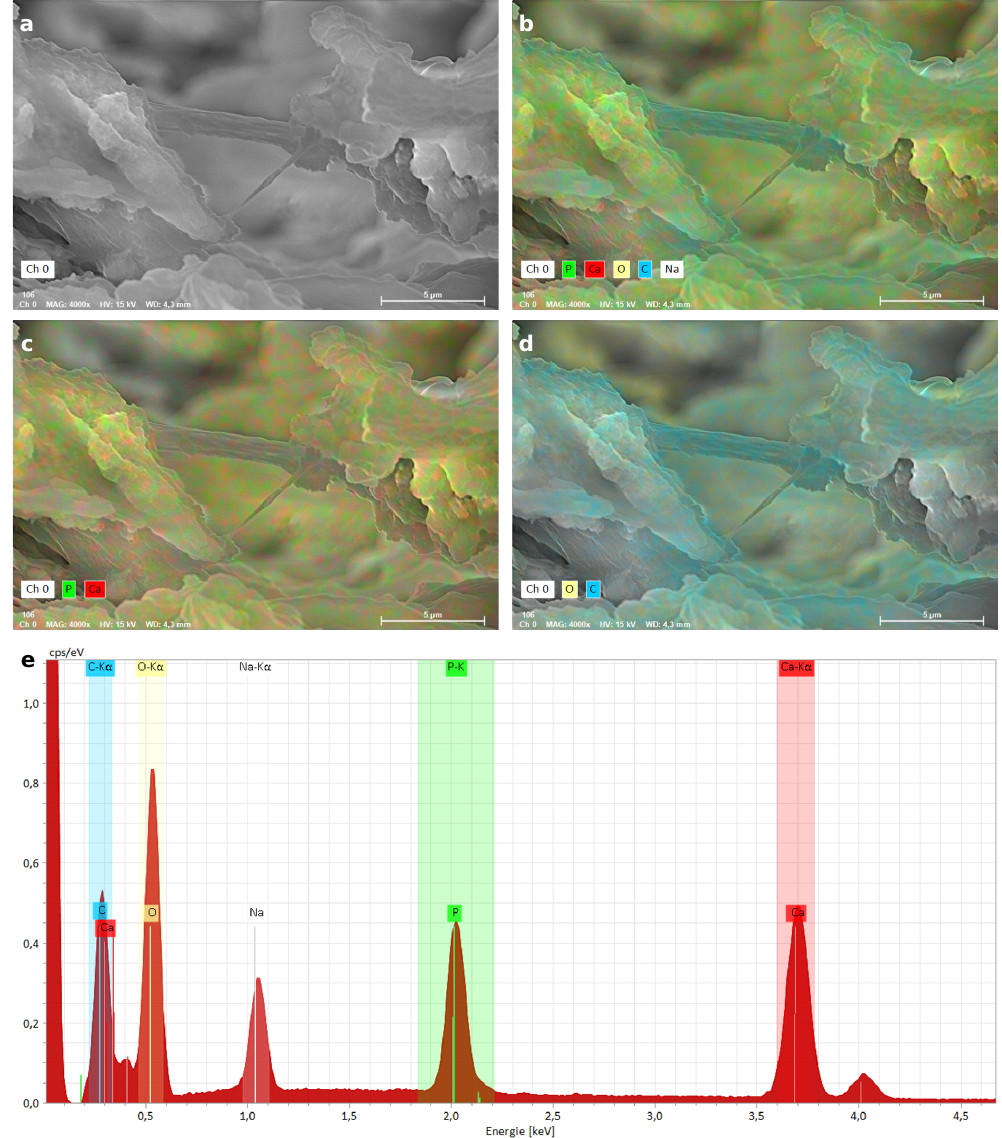
Figure A1. EDX mapping of a supercritically-dried AG33HA67 scaffold. ( a ) SEM picture; ( b ) mapping overlay of carbon (blue), calcium (red), phosphorus (green), oxygen (yellow), and sodium (white); ( c ) mapping overlay of calcium (red) and phosphorus (green); ( d ) mapping overlay of carbon (blue) and oxygen (yellow); ( e ) EDX spectrum of mapping data. The scale bar in mappings is 5µm; voltage 15kV; working distance